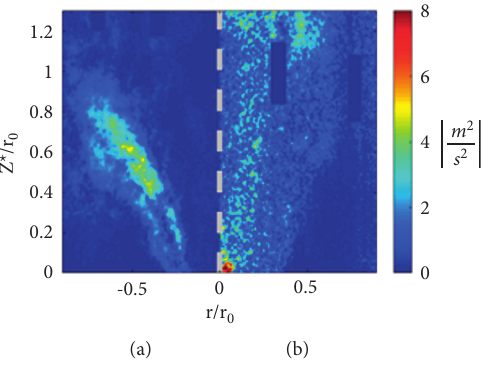
Figure 14: SPOD spatial energy distribution of U ′ V ′ for no PIM (a) and PIM (b) results for the first mode at 312